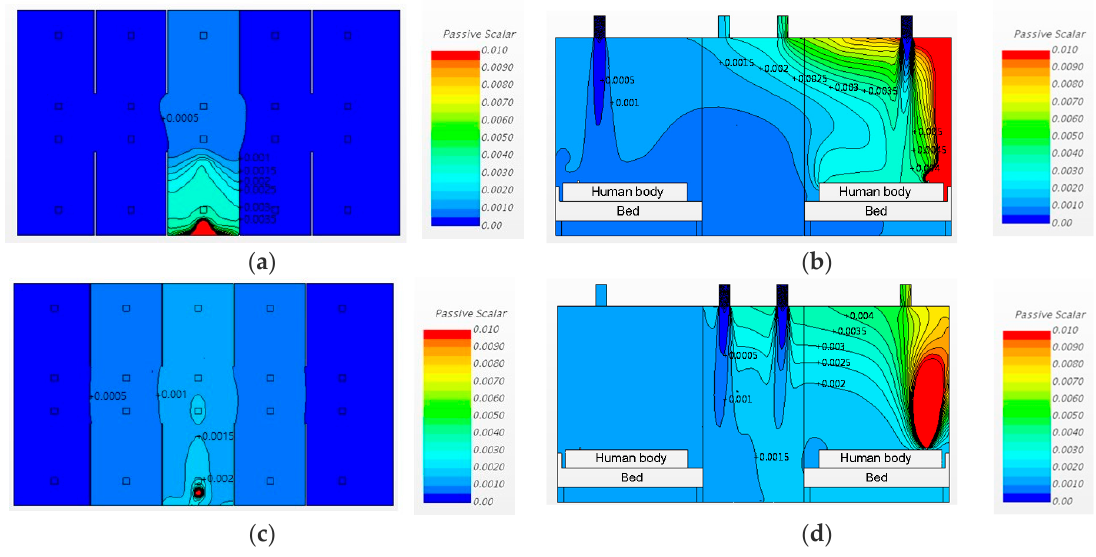
Figure 10. Airflow patterns and pathogen concentrations for Cases 5 and 6: ( a ) Case 5, plan view (h = 1.0 m); ( b ) Case 5, sectional view; ( c ) Case 6, plan view (h = 1.0 m); ( d ) Case 6, sectional view.